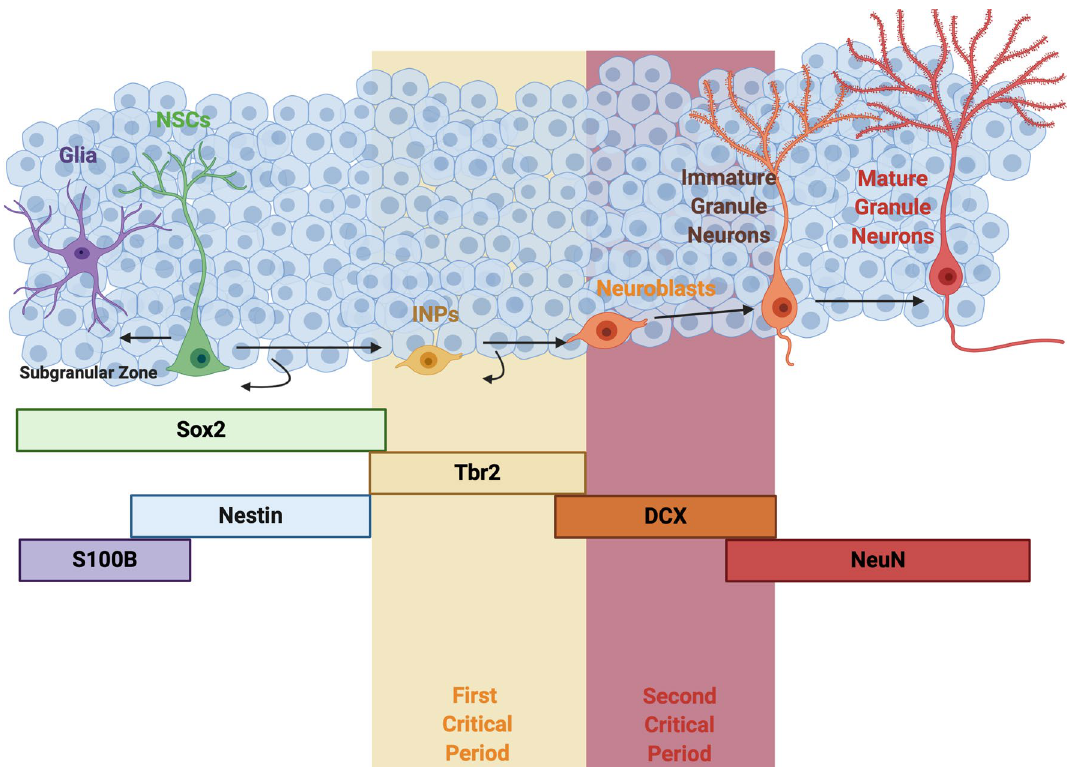
Figure 1. Developmental trajectory and associated markers of hippocampal adult neurogenesis. The developmental trajectory of NSCs within the SGZ is shown. One cycle of neurogenesis, encompassing the transition from neuroprogenitor to neuron, occurs approximately over 30 days. Key developmental stages and associated markers are delineated. Highlighted by the yellow band, the first critical period predominantly encompasses the population of cells transitioning to the neuroblast stage while the second critical period, highlighted in red, encompasses the transition of neuroblasts to immature granule